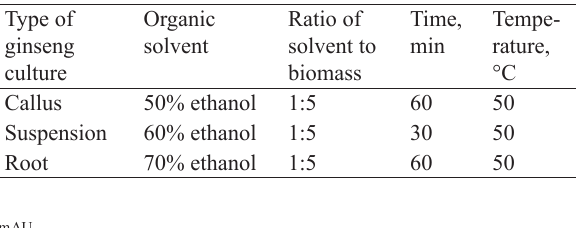
Figure 6 NMR spectrum of mangiferin isolated from ginseng extracts